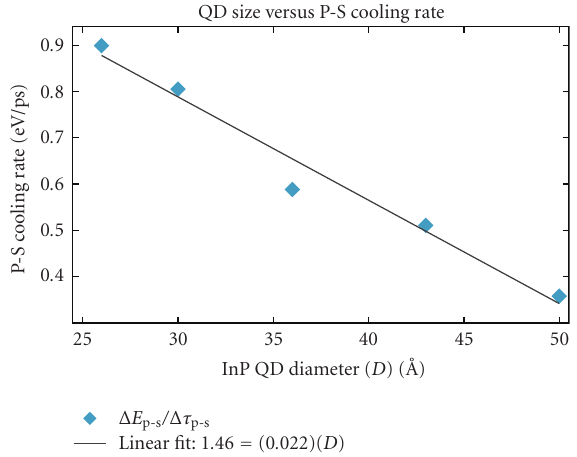
Figure 6: Carrier cooling rate increases as size of quantum dot decreases (from